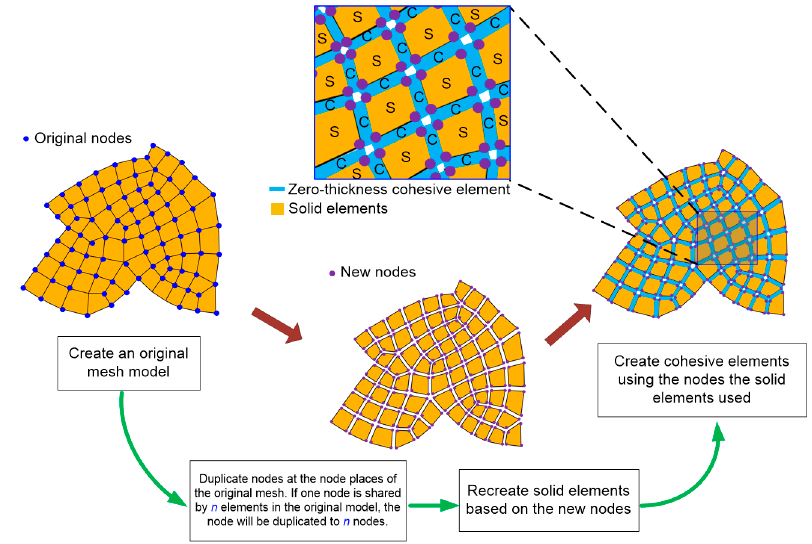
Figure 1. The process of generating zero-thickness cohesive elements at every solid element interface. Note that a solid element and its neighboring cohesive element are connected by sharing two common nodes, and two adjacent cohesive elements connect to each other by sharing one node.